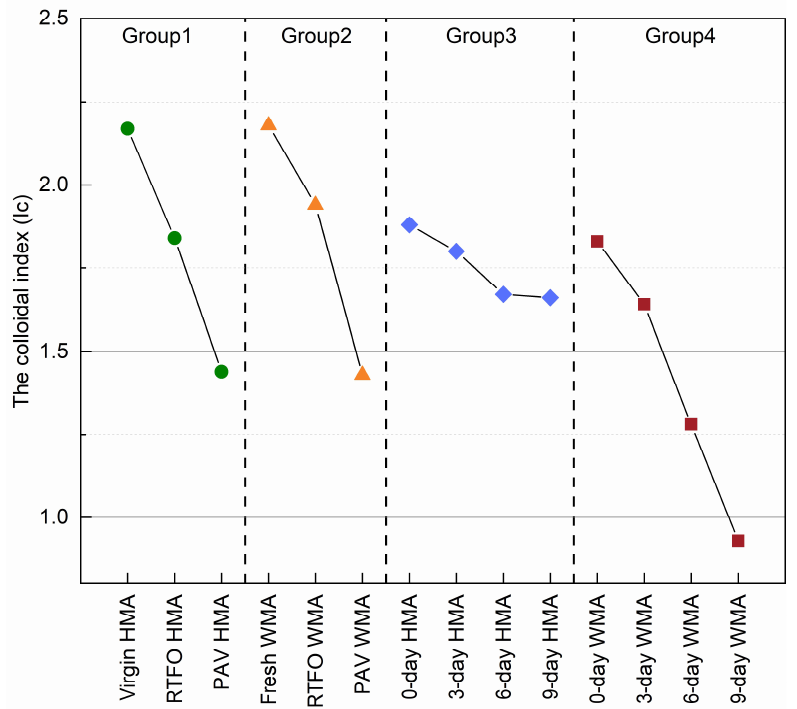
Figure 12. Change in Ic of all binder as the function of ageing.